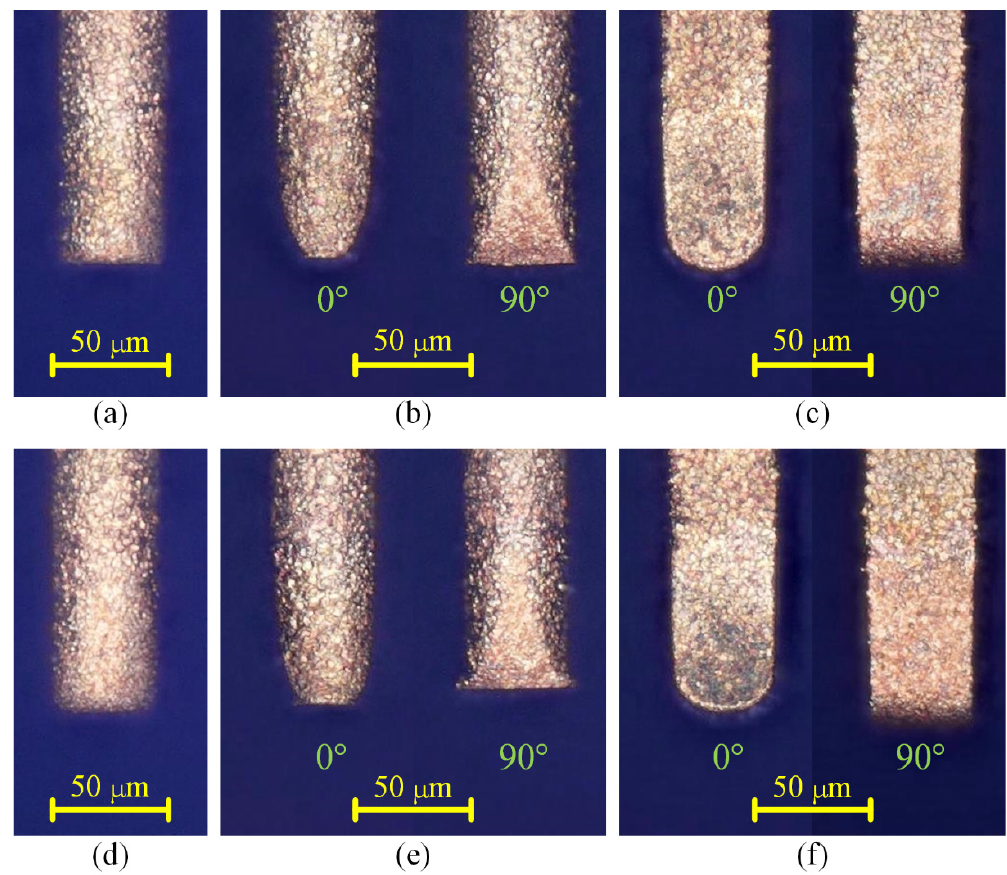
Figure 15. SEM images of the six microgrooves in Exp. 1: ( a ) cylindrical electrode-rotating mode-unidirectional path; ( b ) cylindrical electrode-nonrotating mode-unidirectional path; ( c ) square electrode-nonrotating mode-unidirectional path; ( d ) cylindrical electrode-rotating mode-reciprocating path; ( e ) cylindrical electrode-nonrotating mode-reciprocating path; ( f ) square electrode-nonrotating mode-reciprocating path.